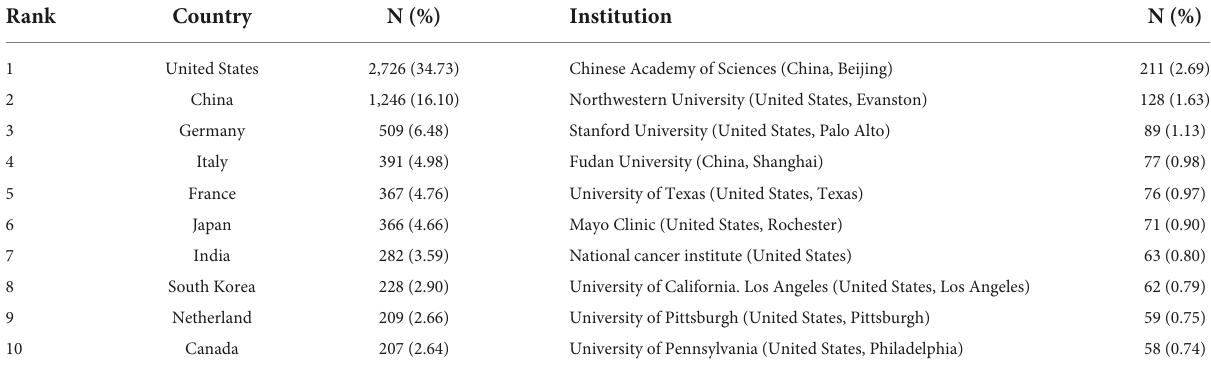
TABLE 2 The top 10 countries and institutions contributed to publications in the research on the association of rare earth elements with cancer [n